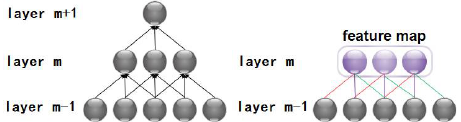
Figure 5. Schematic diagram of CNN local connection.